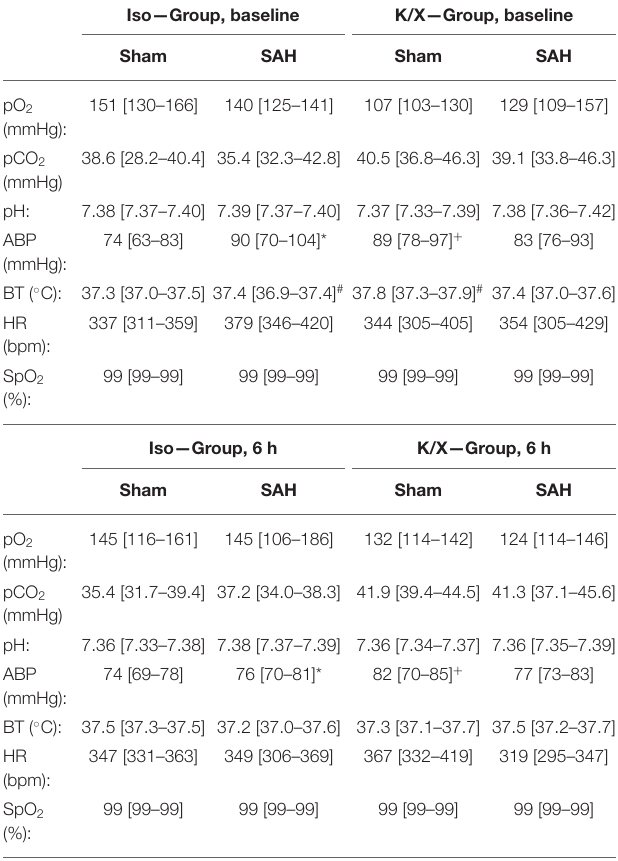
TABLE 1 | Physiological parameters at baseline and after